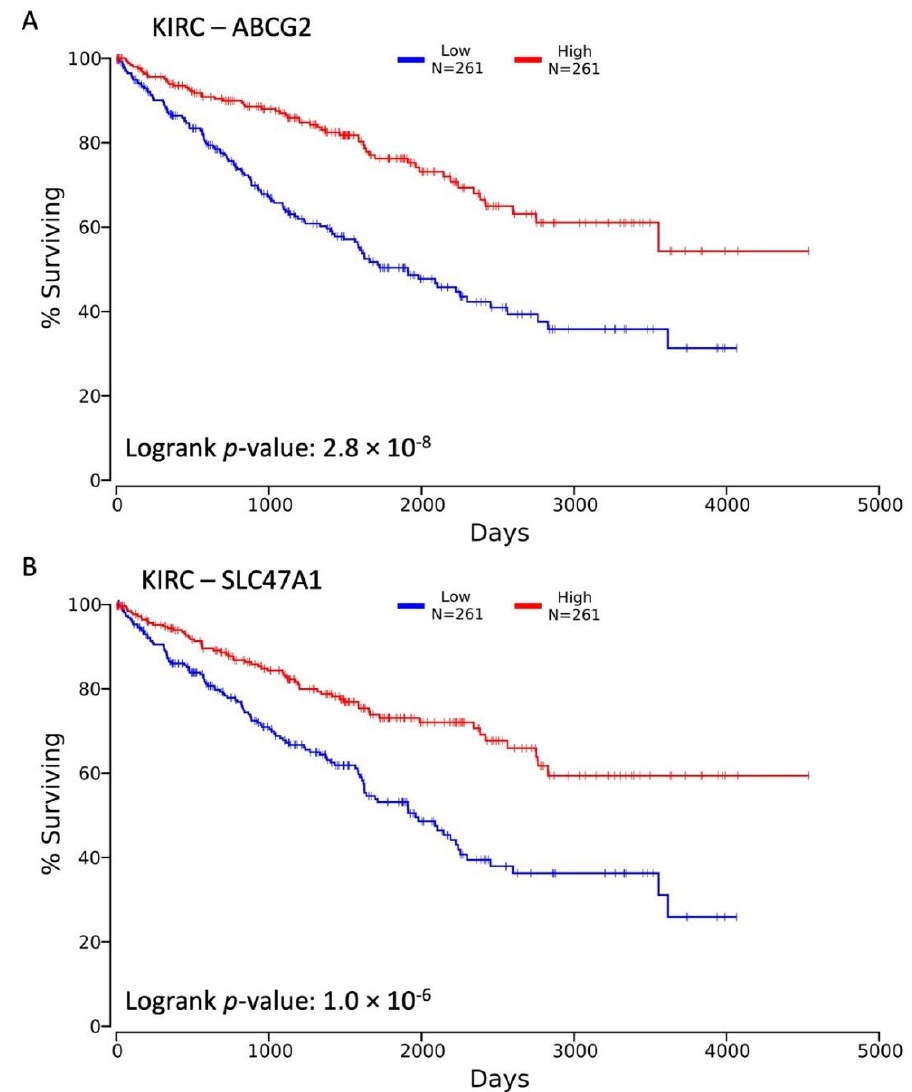
Figure 6. Kaplan–Meier plots for selected SLC22 interacting genes in KIRC. Association of ABCG2 and SLC47A1 and overall survival in KIRC is significant using Cox proportional hazards regression model and the Cox coefficient is negative indicating that higher expression is observed in patients with longer survival. This relationship is shown by Kaplan – Meier plot in KIRC for ABCG2 ( A ) and SLC47A1 ( B ). The red line represents patients with gene expression above the median for the gene of interest; the blue line represents patients with gene expression below the median. The p -values associated with logrank tests comparing the halves are also shown.